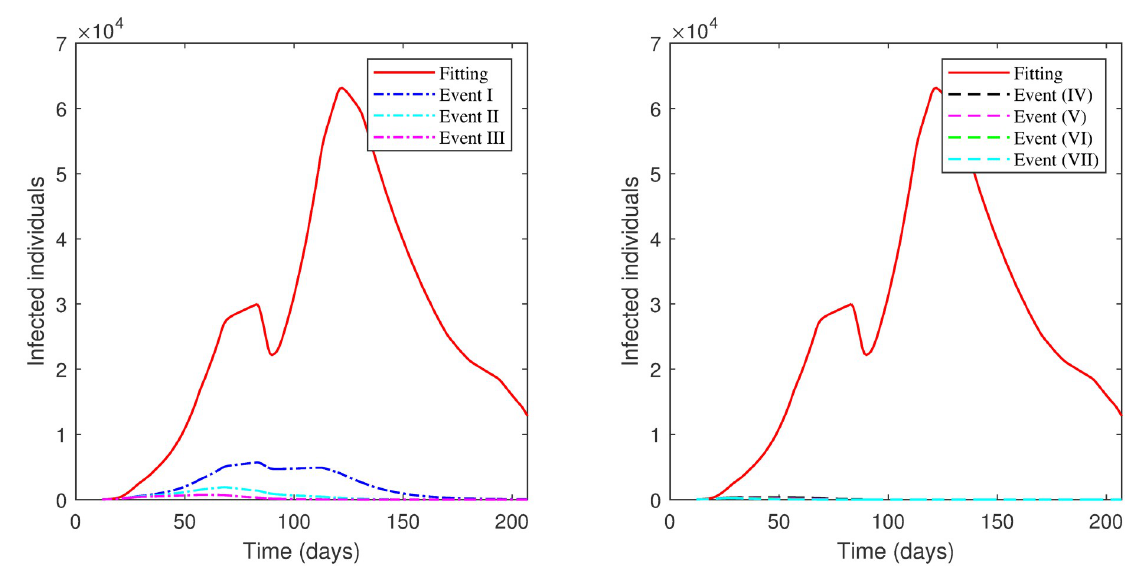
Fig 16. Numerical solution of model (1) for infected compartment vs. time for 4 th scenario of Second Case.